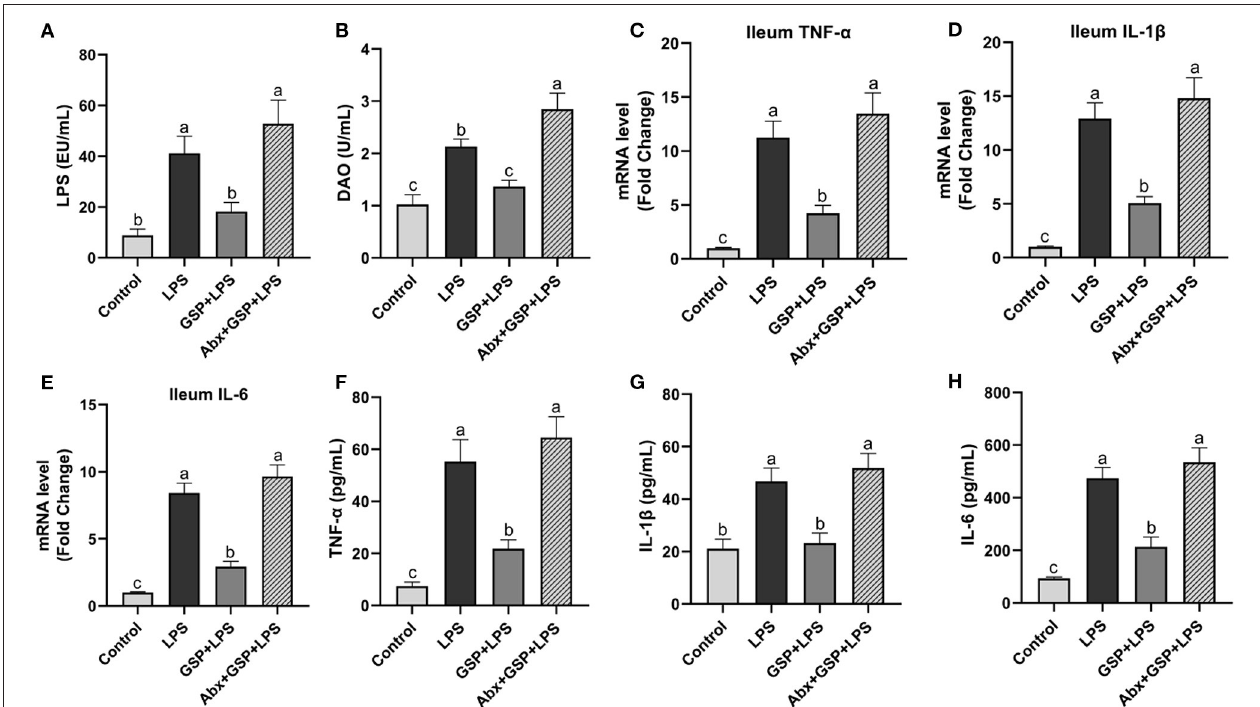
FIGURE 1 | The inflammatory cytokines in serum and the inflammatory cytokine gene expressions in ileum of C57BL/6 mice with different treatments in Experiment 1. (A) Serum lipopolysaccharide (LPS), (B) diamine oxidase (DAO), (C–E) the ileal inflammatory cytokine gene expression of tumor necrosis factor- α (TNF- α ), interleukin-1 β (IL-1 β ) and IL-6, and (F–H) serum TNF- α , IL-1 β , and IL-6. Control, control group that oral gavaged with physiological saline before i.p. PBS injection; LPS, a LPS injection group that oral gavaged with physiological saline before i.p. LPS injection; GSP + LPS, a GSP administration group that oral gavaged with 250 mg/kg GSP before i.p. LPS injection; Abx + GSP + LPS, an antibiotic group that given a mixture of antibiotics in drinking water before the Experiment 1, and then coupled with GSP before i.p. LPS injection. Data are presented by the mean ± SEMs ( n = 6). Bars with no letter in common are significantly different, p ≤